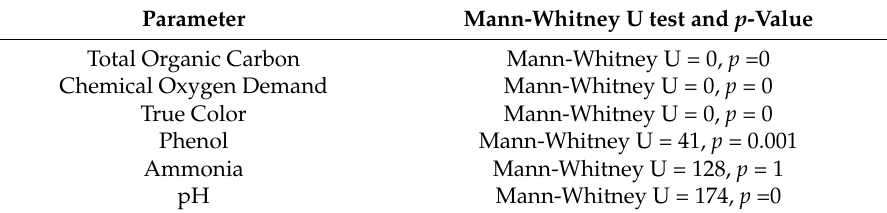
Table 4. Mann-Whitney U-Test statistic and p -value for wet and dry